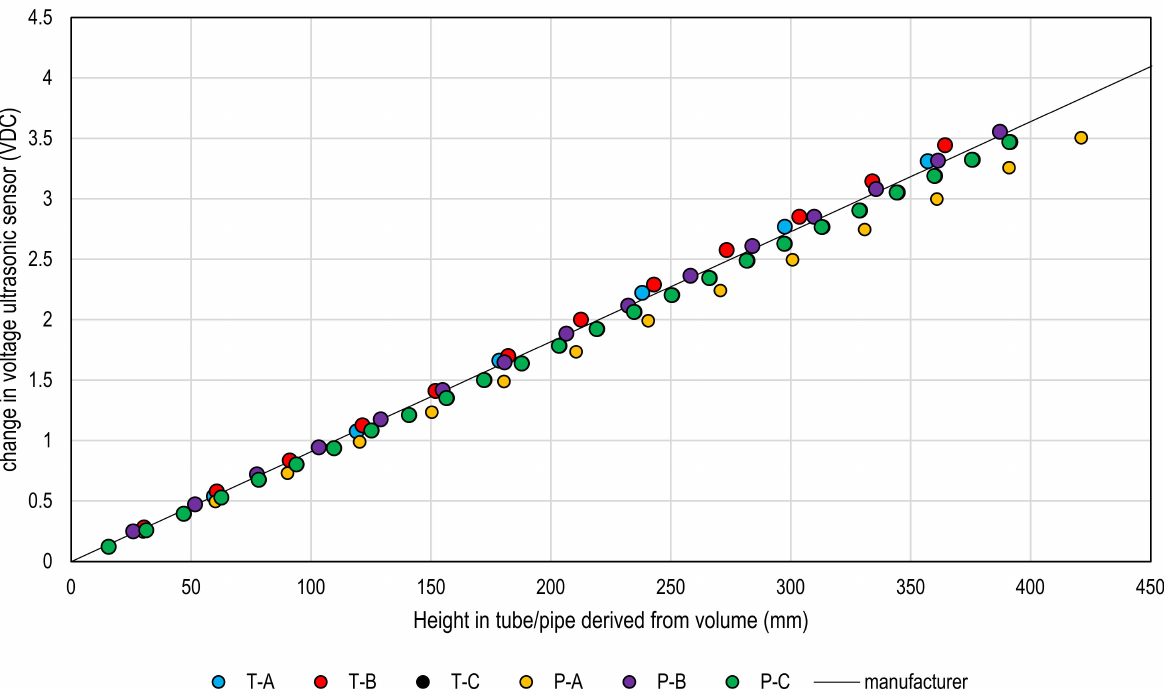
Figure 2. Linear regression of height of water added ( x axis) vs. change in voltage from the sensor ( y axis) of each tube and pipe. The black line represents the manufacturer’s calibration